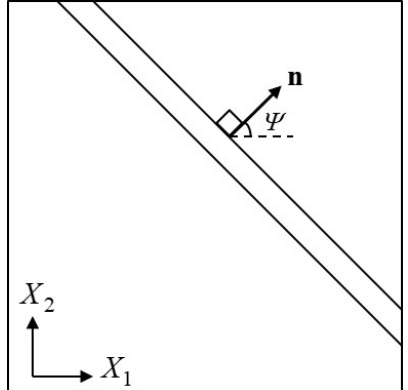
Figure 18. Narrow band in biaxially stretched